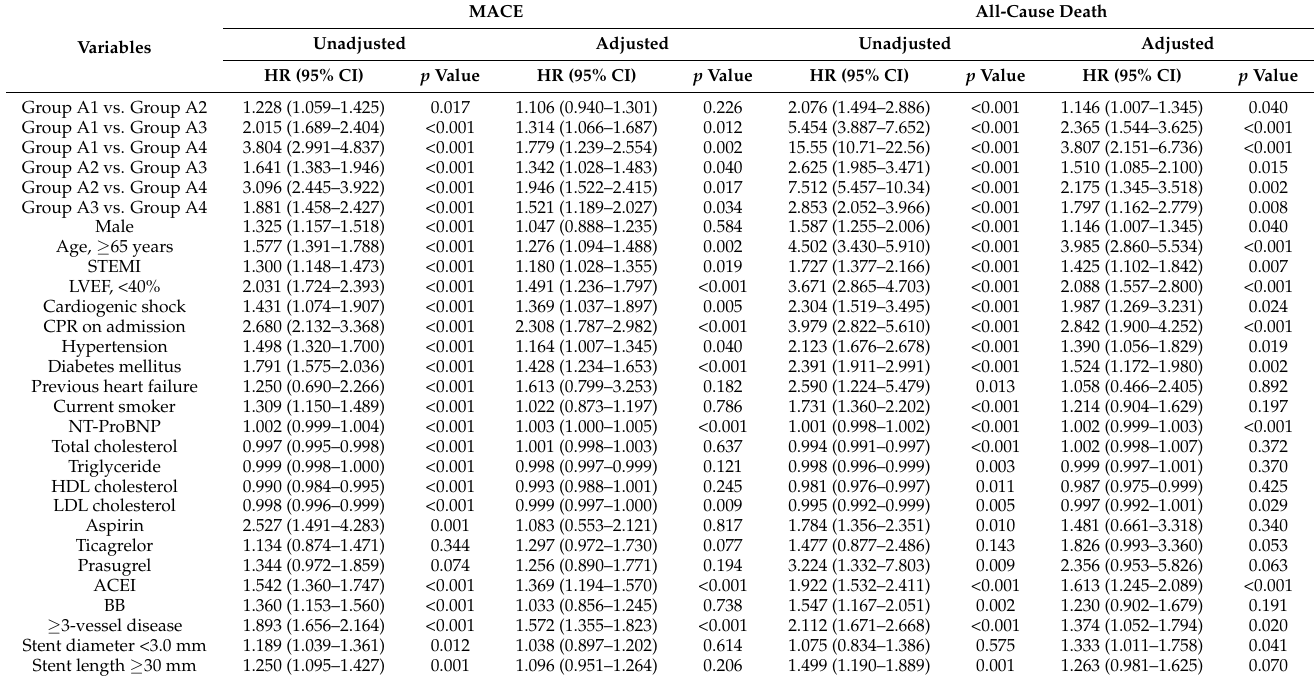
Table 7. Independent predictors for MACE and all-cause death in statin